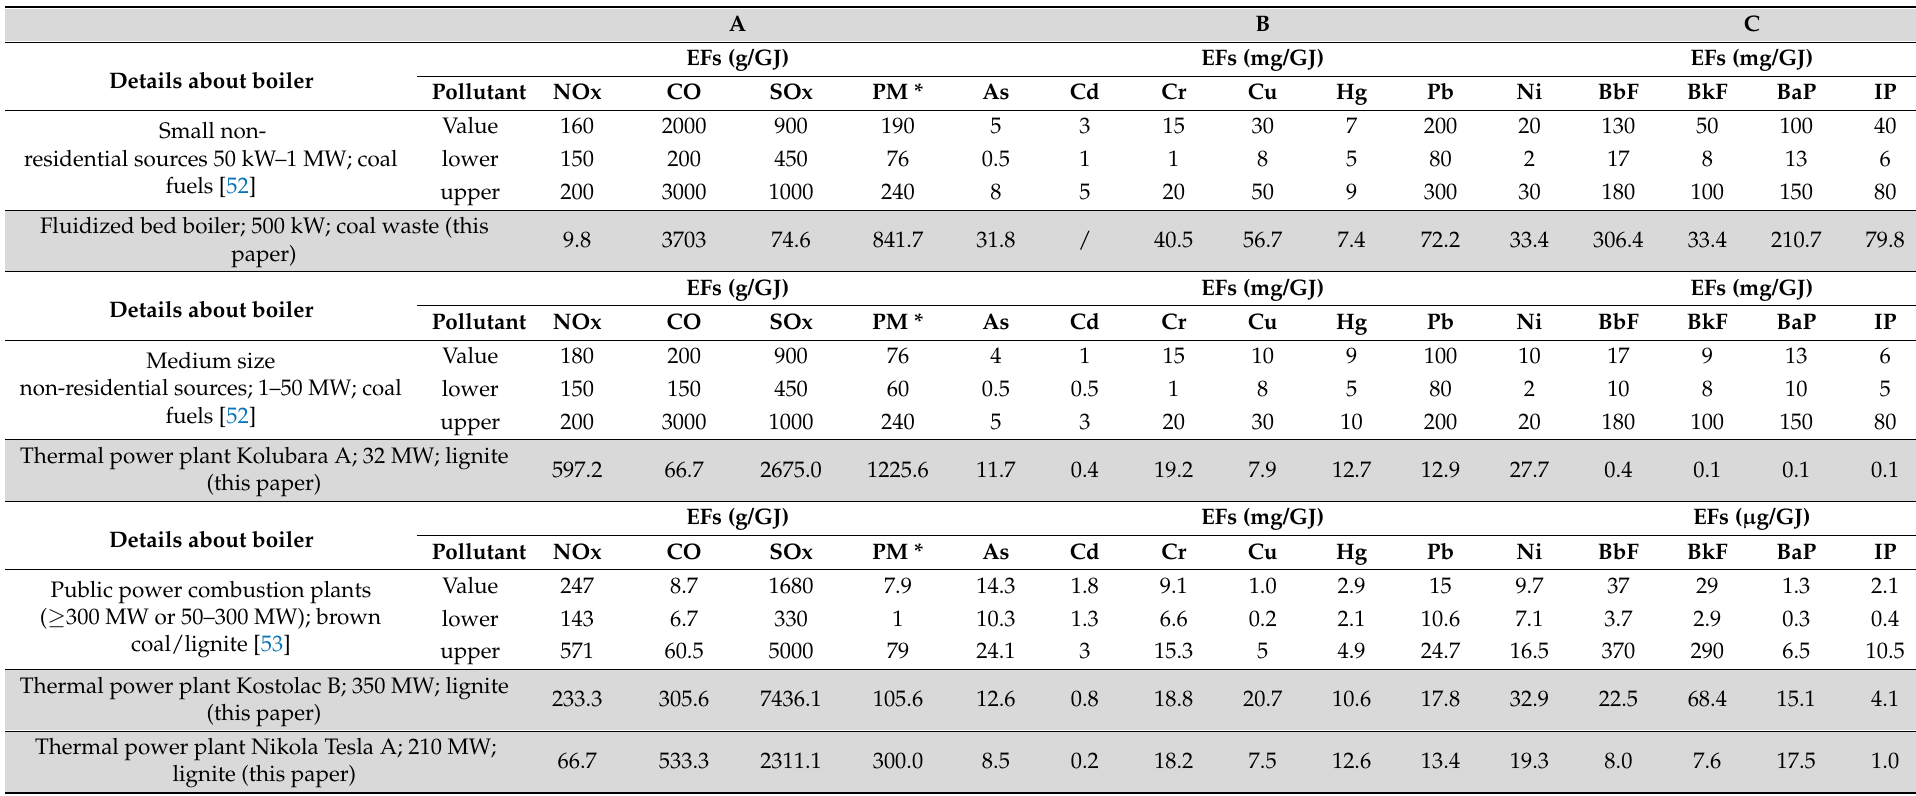
Table 2. Comparison of EF values for NOx, CO, SO 2 , and PM (A), EF values for As, Cd, Cr, Cu, Hg, Ni, and Pb (B) and EF values for BaP, BbF, BkF, and IP (C) determined for the combustion of lignite and coal waste with literature data. A B